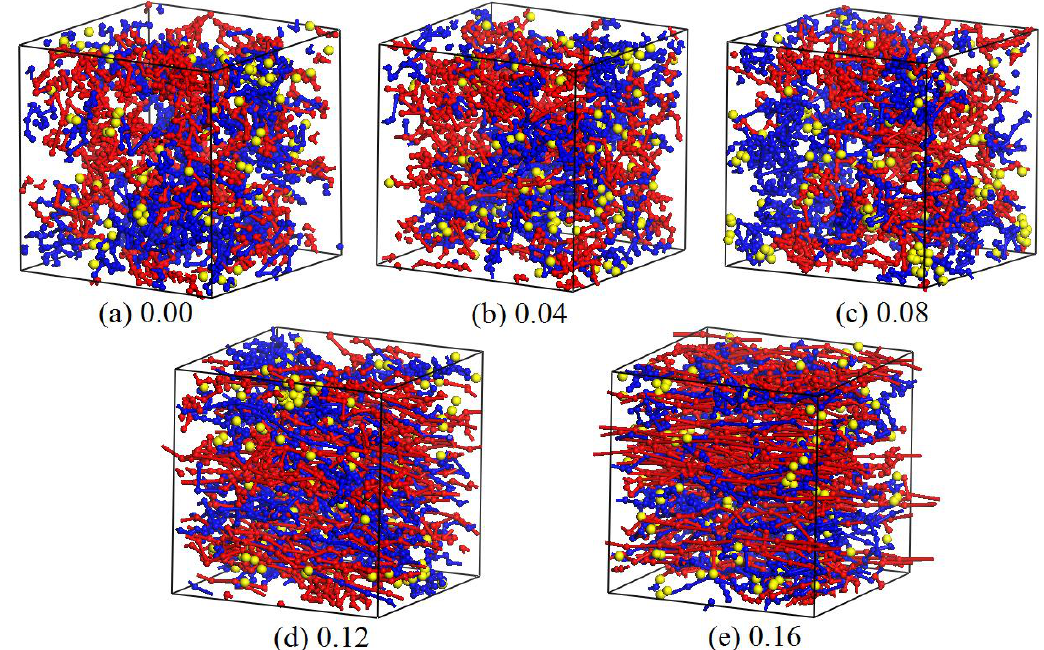
Figure 14. Equilibrated morphologies of 10% PVA/10% PAM/1.5% nano-silica blended hydrogels under different shear rates of ( a ) 0.00; ( b ) 0.04; ( c ) 0.08; ( d ) 0.12; and ( e ) 0.16.